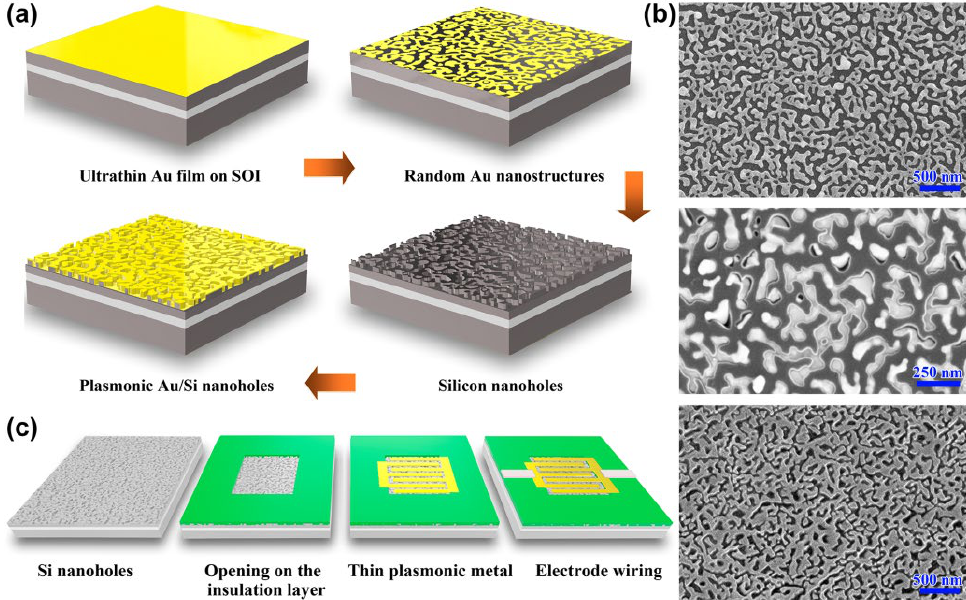
Figure 2. Structure and device fabrication processes of the plasmonic MSM photoconductor. ( a ) Li- thography − free fabrication of the Au/SiNHs nanostructures. ( b ) Au nanostructures by the thermal dewetting method ( top ), MACE etched Si with ( middle ) and without ( bottom ) Au etching seeds. ( c ) MSM device fabrication flow.